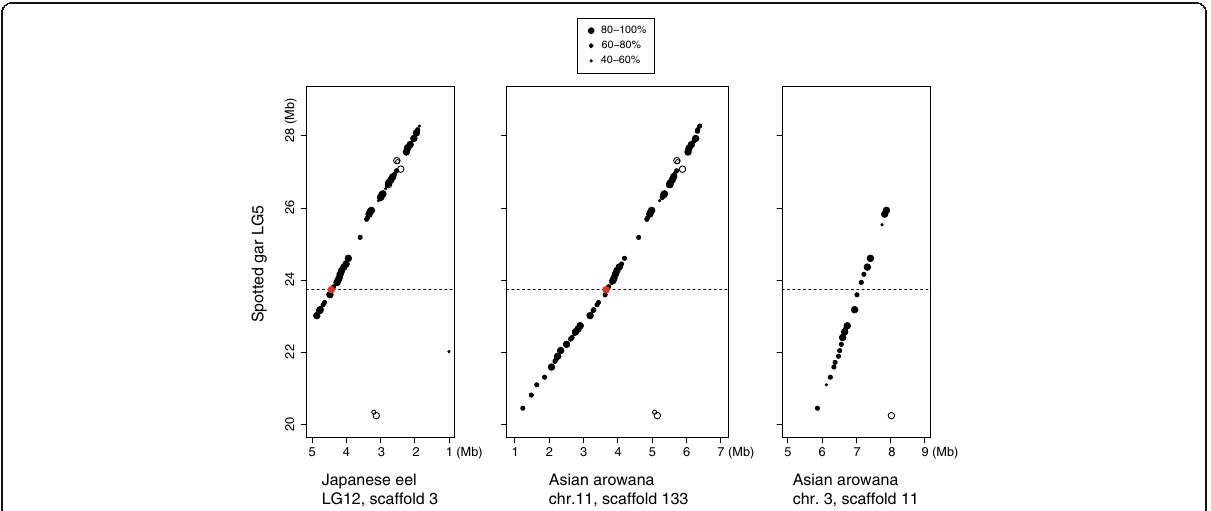
Fig. 2 Dot plot for macrosynteny of rho regionFor Japanese eel scaffold 3, and Asian arowana scaffolds 133 and 11, the positions of genes matched to those in spotted gar ’ s LG5 region (20 – 29 Mb) are plotted. Each of the dots is the midpoint of predicted start and end positions of gene, and the size indicates the degree of amino acid identity (%) to the ortholog in spotted gar; in the same transcriptional direction (closed dot) or opposite direction (open dot). The rhodopsin gene is colored in red and the position in spotted gar ’ s LG5 is shown in dashed line.